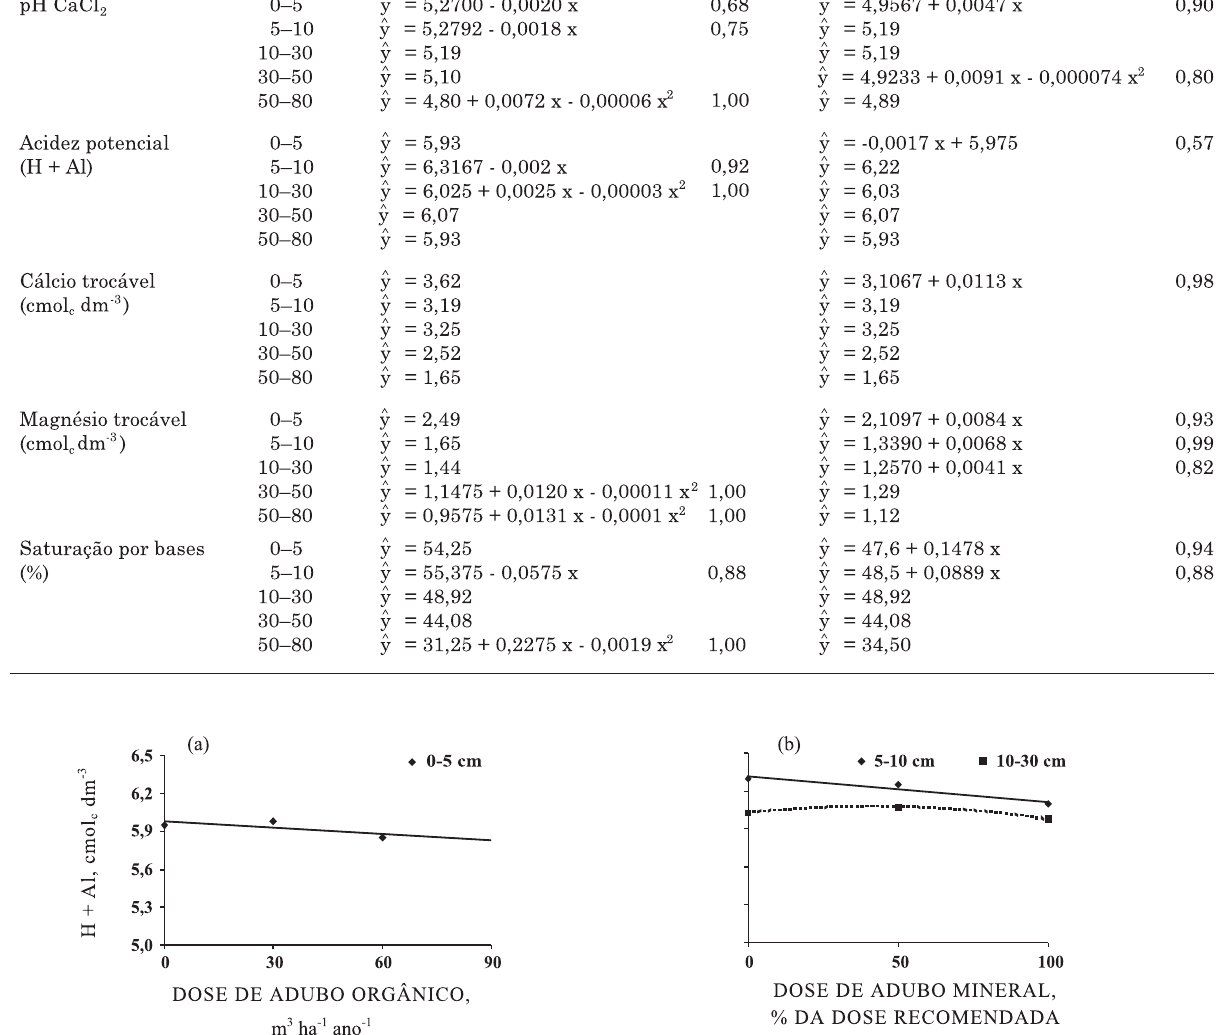
Figura 2 .Acidez potencial (H + Al) em Latossolo Bruno sob plantio direto submetido a diferentes doses de esterco líquido de gado leiteiro e adubação mineral, por um período de seis anos, com remoção total da planta: (a) adubação orgânica; (b) adubação